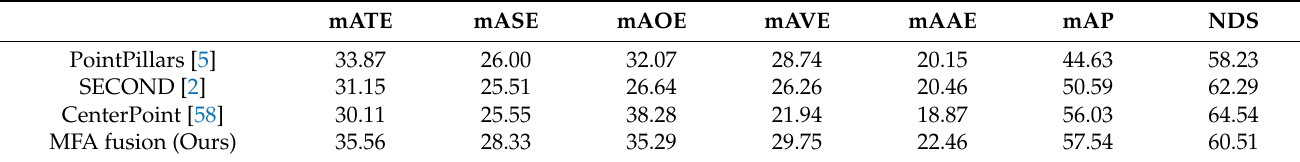
Table 4. Results of detection on the NUSCENES dataset.